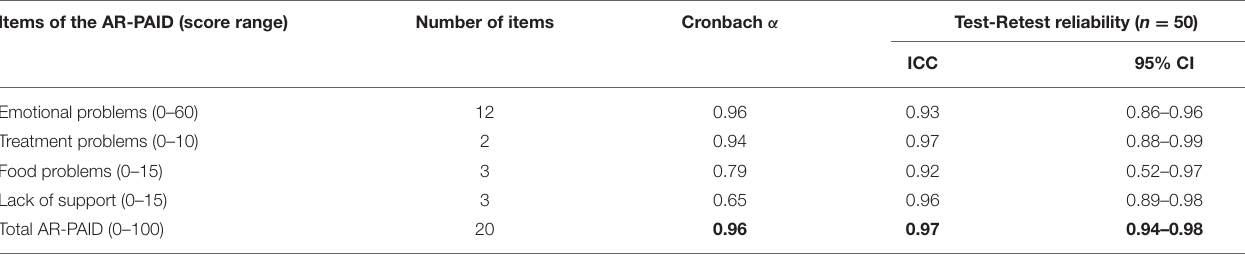
TABLE 5 | Internal consistency and test-retest reliabilities of the AR-PAID ( N = 200). Items of the AR-PAID (score